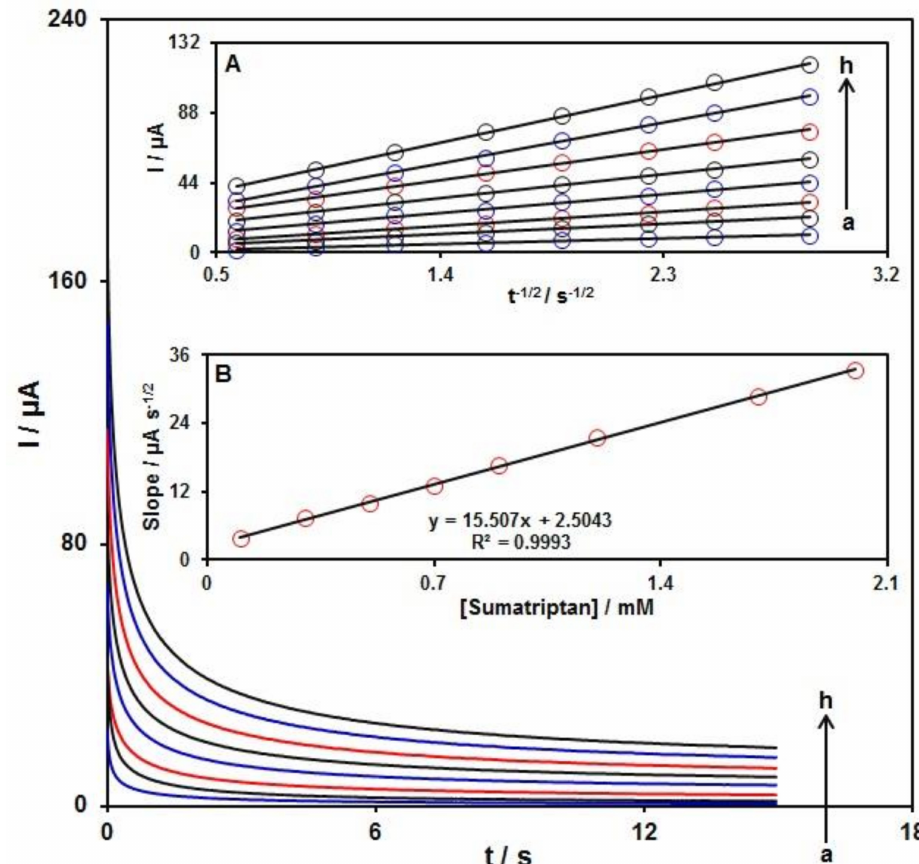
Figure 9. Chronoamperometric behavior of Ni-Co LDH/SPE in PBS (0.1 M; pH = 7.0) at potential of 660 mV for variable sumatriptan contents (a–h: 0.1, 0.3, 0.5, 0.7, 0.9, 1.2, 1.7, and 2.0 mM). Insets: ( A ) Plots of I vs. t − 1/2 and ( B ) plots of the slopes from the straight lines vs. sumatriptan